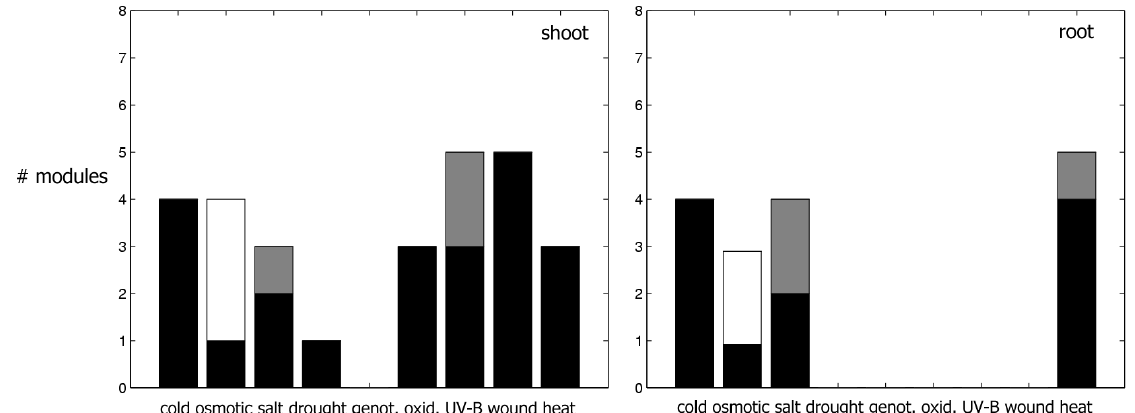
Figure 2: Number of significant modules detected under the respective initial conditions in the shoot and root tissues. Single response modules are represented by black, IR modules by grey and coherent modules by white